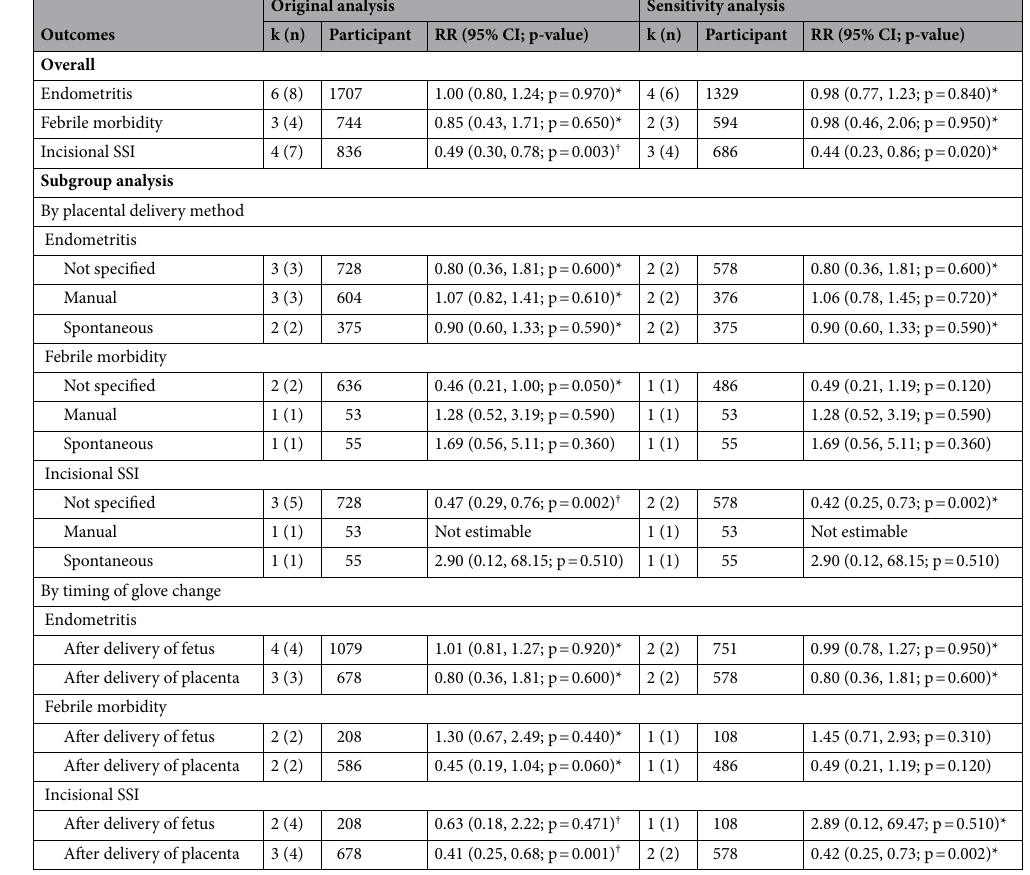
Table 2. Effects of intervention and sensitivity analysis. k, number of studies; n, number of effect sizes; RR, risk ratio; CI, confidence interval; SSI, surgical site infection; Manual, manual placental removal method; Spontaneous, spontaneous placental removal method. *Two-level meta-analysis; †three-level